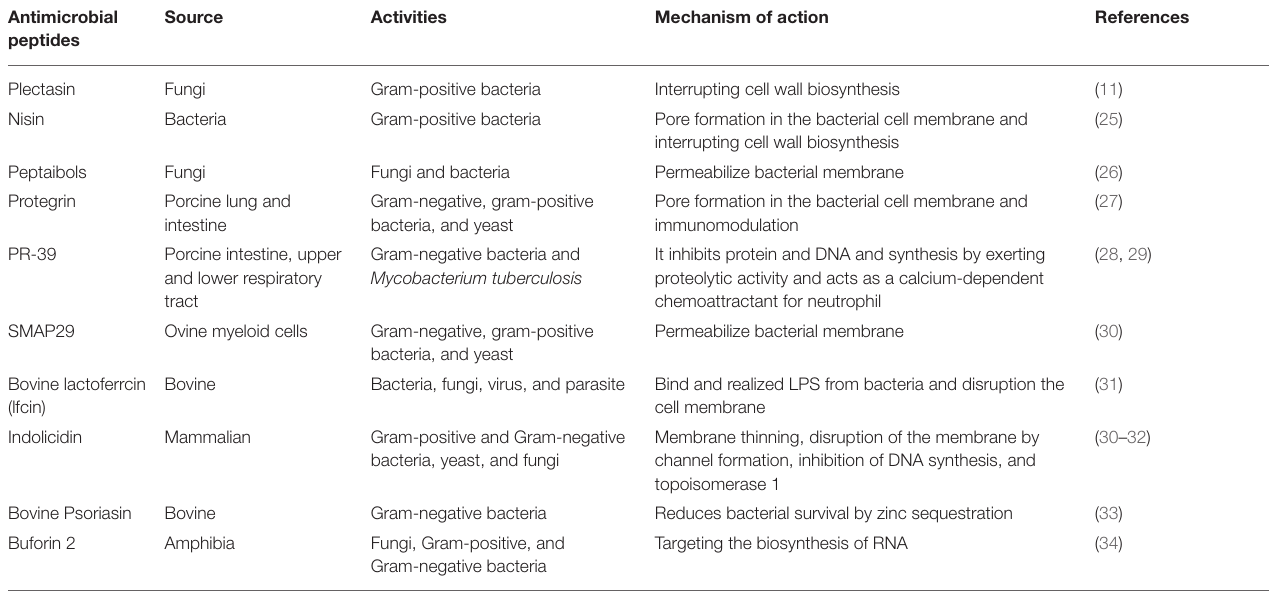
TABLE 1 | Summary of some selected AMPs and their mechanisms of action. Antimicrobial